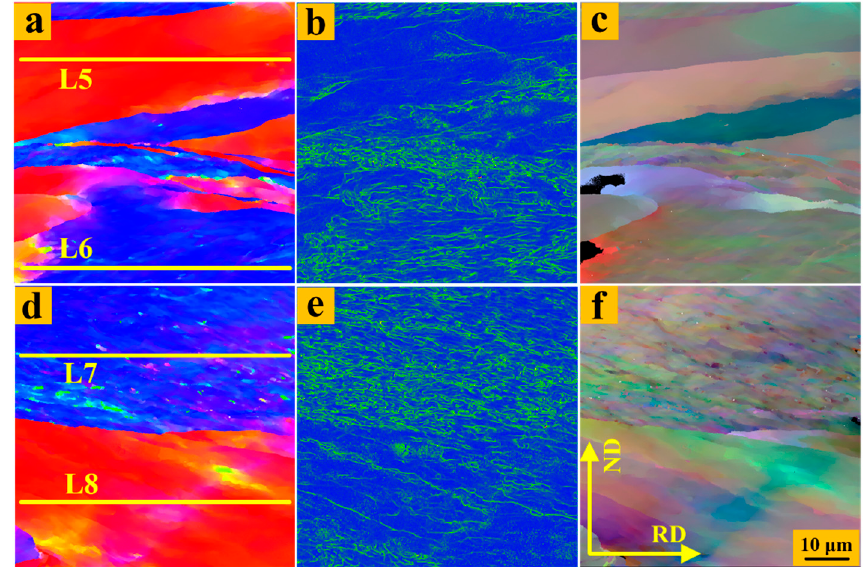
Figure 6. Microstructures of 87% CR-Ta specimens in regions ‘R2’ and ‘R4’, respectively. ‘R2’: ( a ) IPF map; ( b ) KAM; ( c ) GROD-Hyper. ‘R4’: ( d ) IPF map; ( e ) KAM; ( f ) GROD-Hyper. Step size: 60 nm.